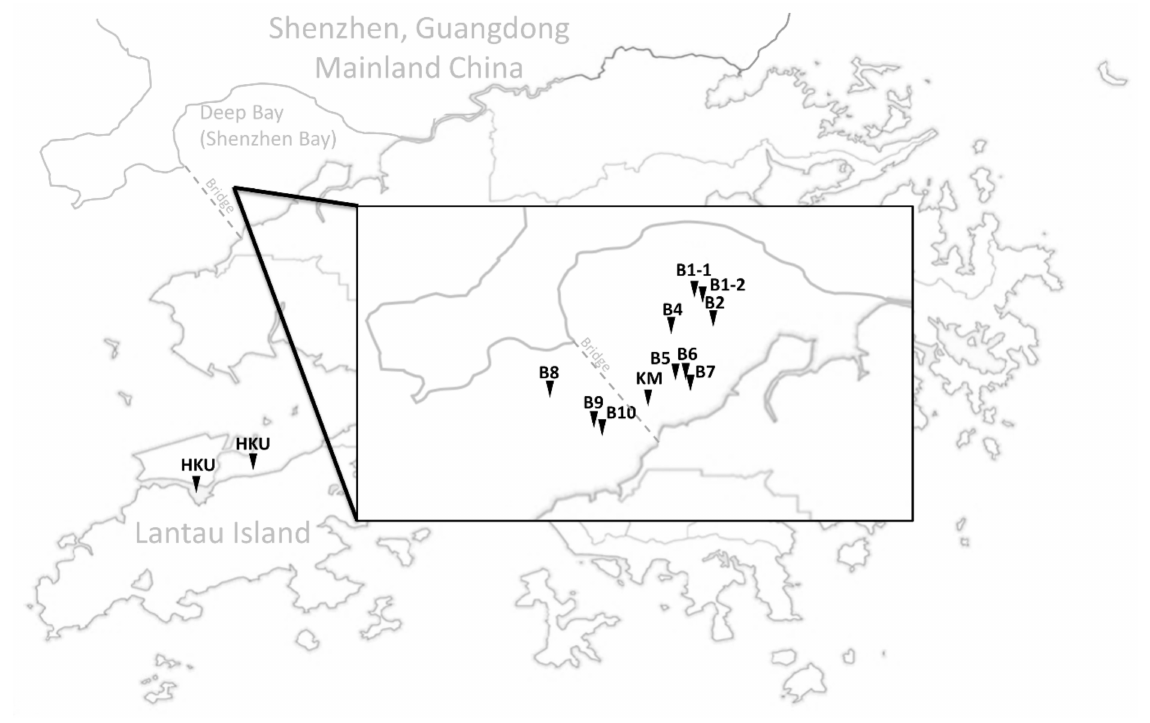
Figure 1. Localities of the 49 collected Hong Kong oyster M. hongkongensis